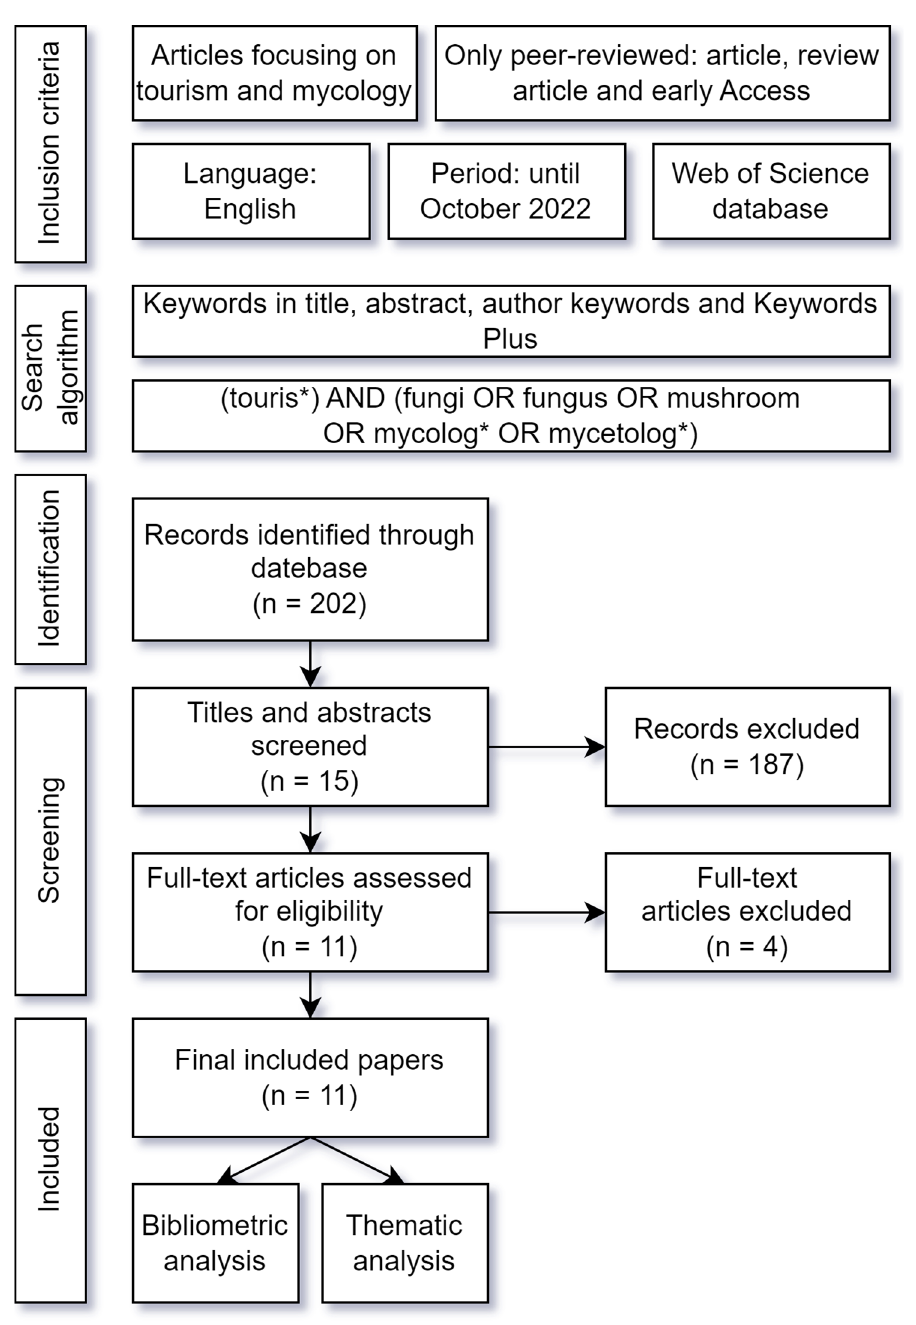
Figure 1. Review protocol. Own elaboration. * The asterisk has been used in the search algorithm to capture all derived words.